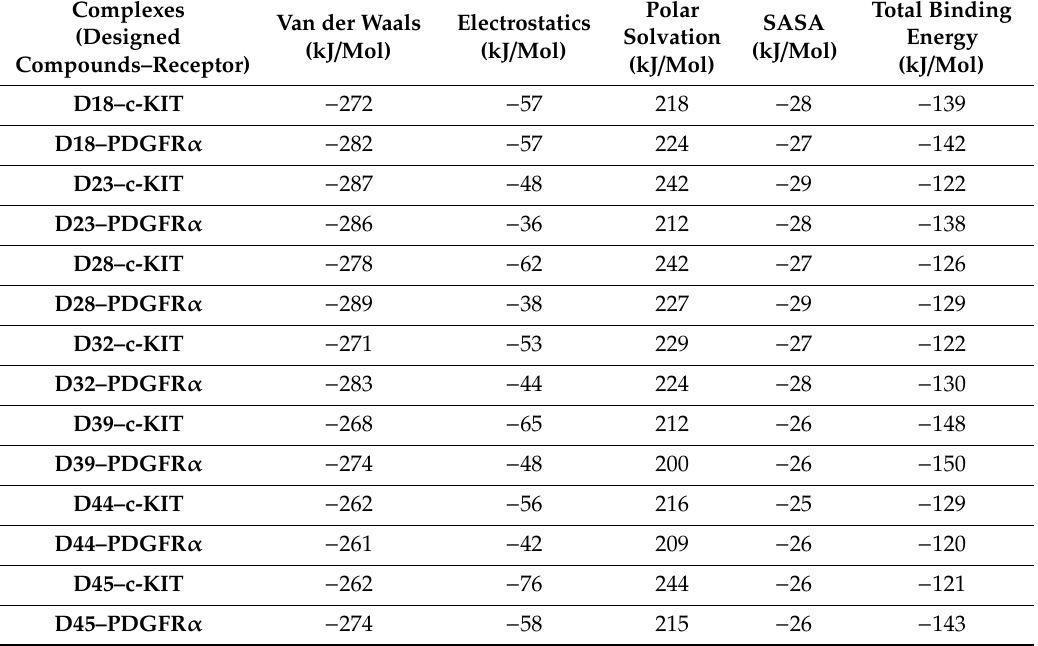
Table 6. The energy contributions of the various energetic terms (Van der Waals energy, electrostatic energy, polar solvation energy, and non-polar solvation energy / SASA) to the total binding energies are shown for the designed